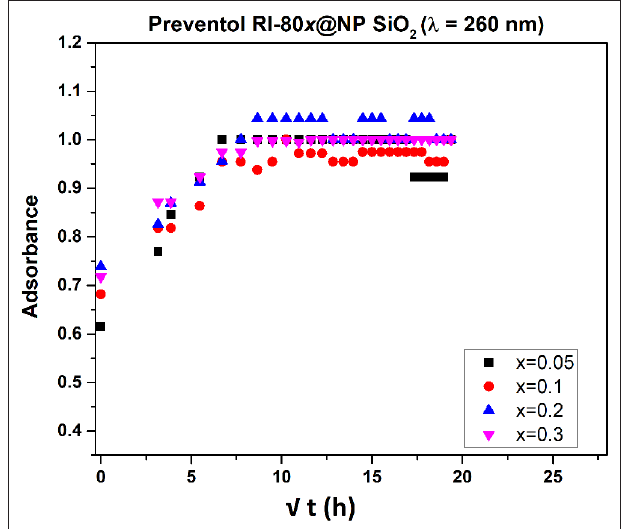
FIGURE 5 | Release profile of Preventol RI-80 from MSN loaded with different amounts of Preventol RI-80 ( λ =